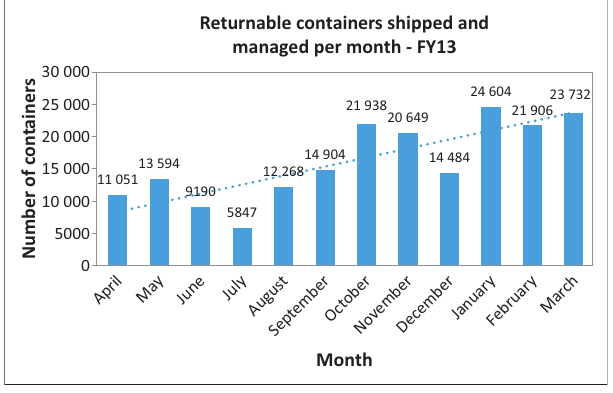
Source : Toyota South Africa Motors (TSAM), 2013, Toyota South African Motors sustainability report 2013 , TSAM, Pretoria FIGURE 3: Toyota South Africa Motors’ returnable container